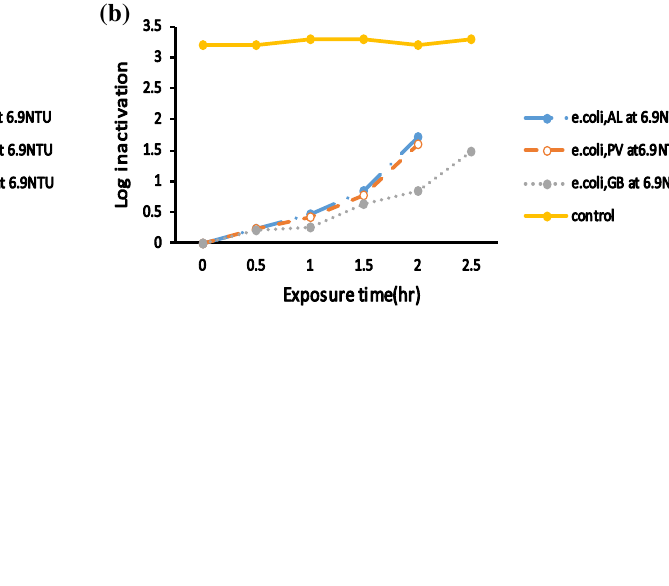
Temperature concentrating potential of concentrators at 3.41 NTU. c Temperature concentrating potential of concentrators at 6.9